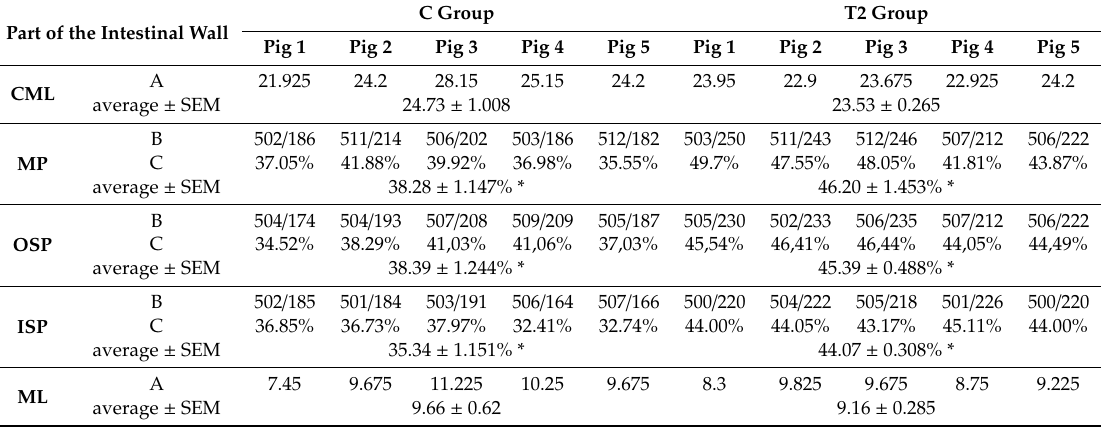
Table 1. Nitric oxide synthase (nNOS)-like immunoreactive perikarya and nerve fibers in porcine duodenum under physiological conditions (C group) and after administration of T2 toxin. Part of the Intestinal Wall